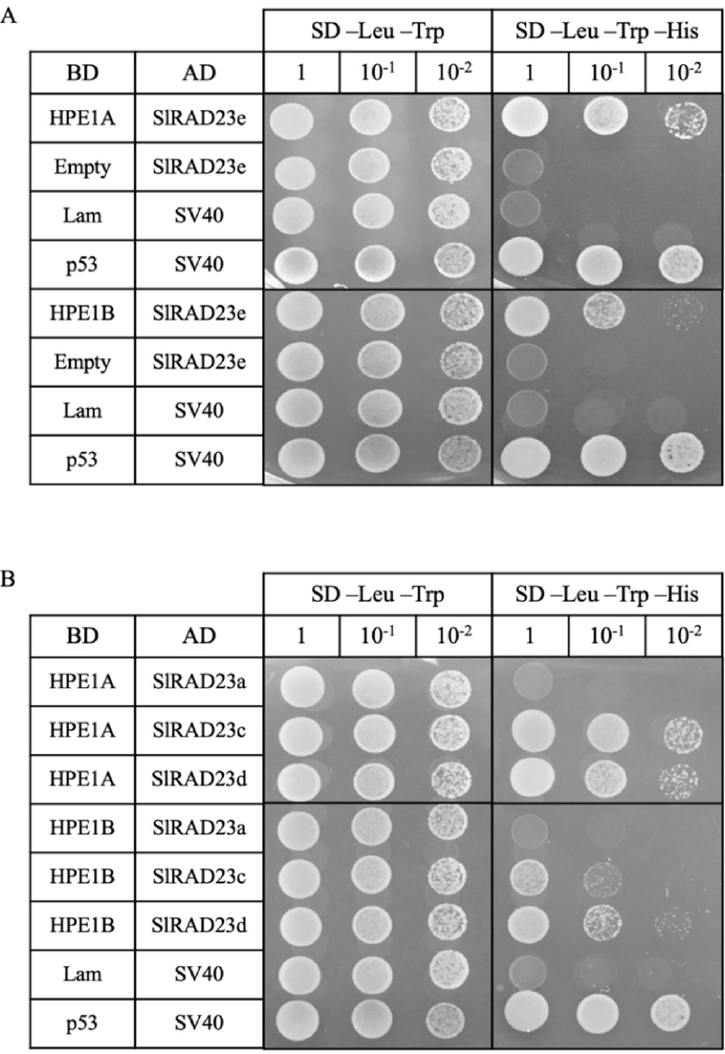
Figure 2. Validation of HPE1 and RAD23 interactions by directed Y2H. ( A ) Y2H test of interaction between SlRAD23e and the HPE1 from LsoA and LsoB. pGBKT7 (BD) constructs were used as bait, and pGADT7 (AD) constructs were used as prey in Y2H. Lam + SV40 indicates negative control for Y2H; p53 + SV40 indicates positive control for Y2H. ( B ) Interaction between HPE1 proteins and the other SlRAD23 proteins.